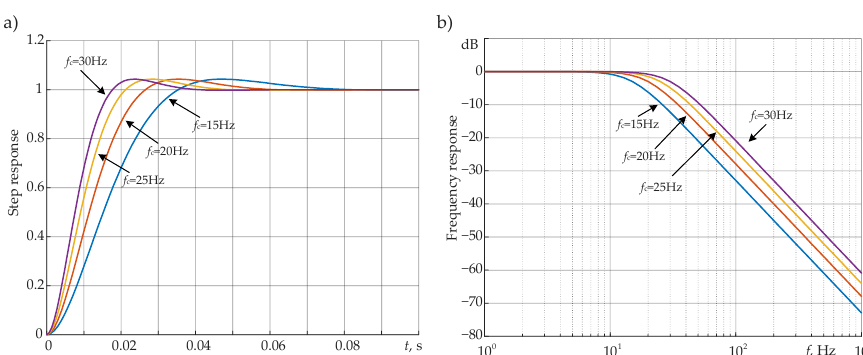
Figure 12. Step ( a ) and frequency ( b ) responses of low pass filter for different cut-off frequencies f c .